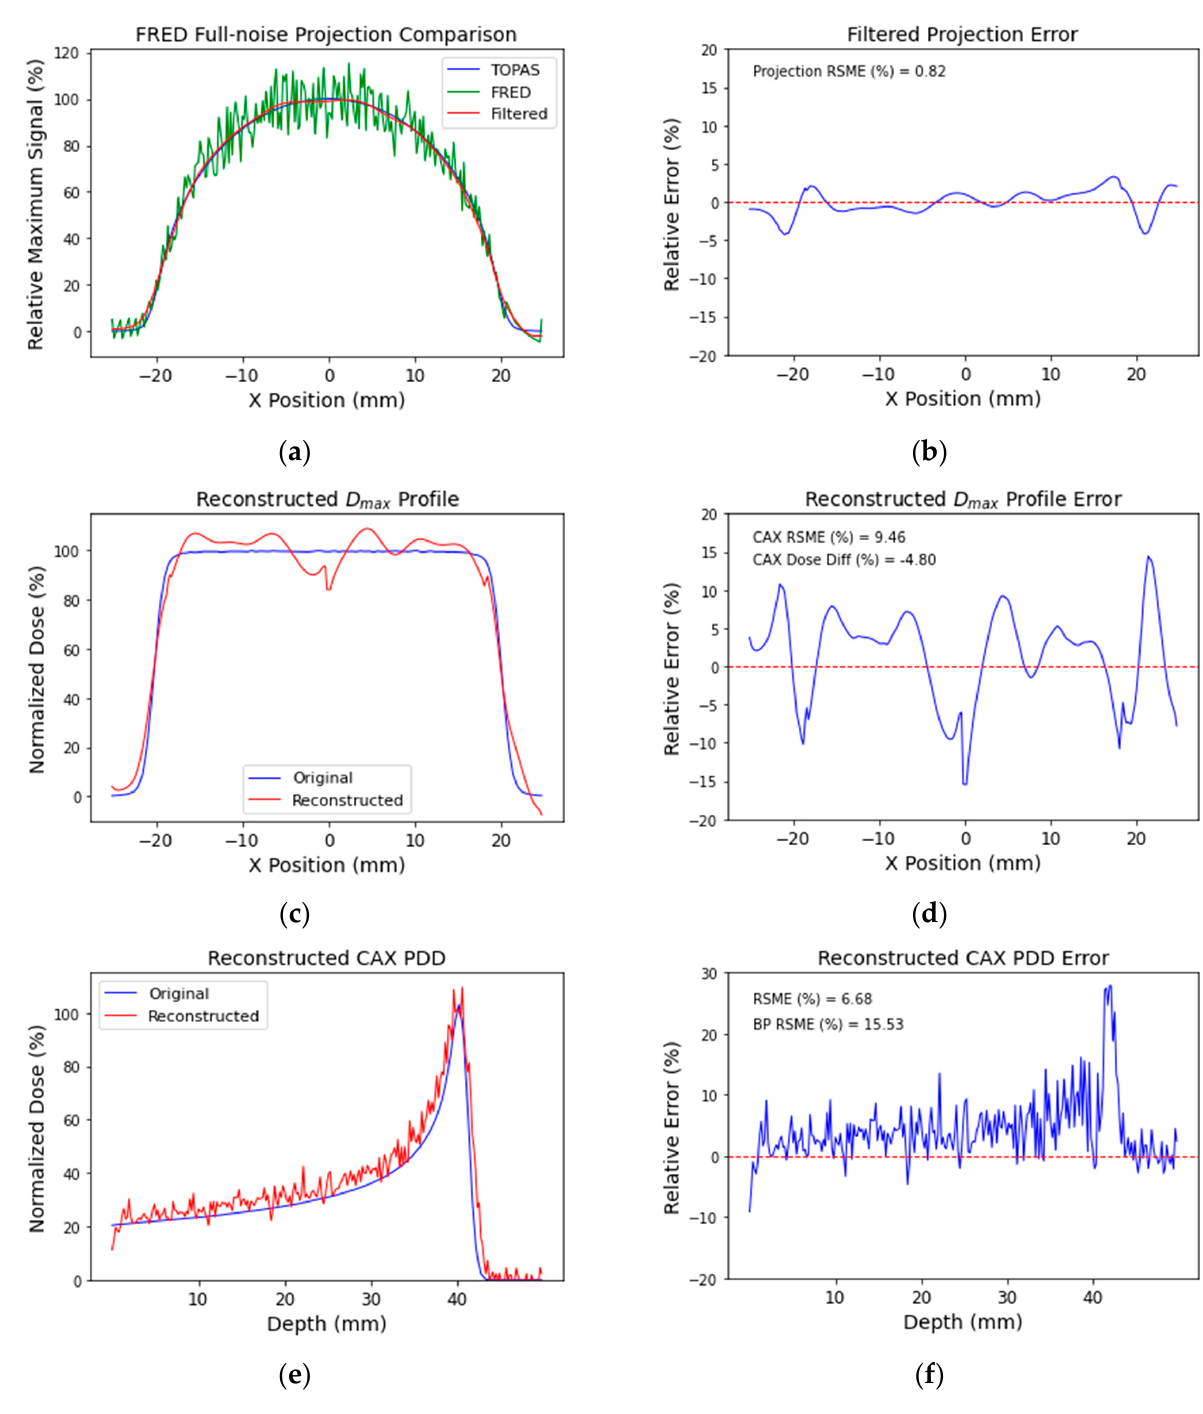
Figure 8. Comparison of full-noise projection data and reconstructed D max profile and CAX PDD. D max profiles through the MC 3D distribution projection, full-noise FRED projection, and the filtered FRED projection ( a ) are compared, and the percentage error between the MC projection and filtered projection is shown in ( b ). The reconstructed D max profile ( c ) and CAX PDD ( e ) are compared with the MC distribution, with the percentage error between the MC data and reconstructed data shown for the profile ( d ) and PDD ( f ), respectively.